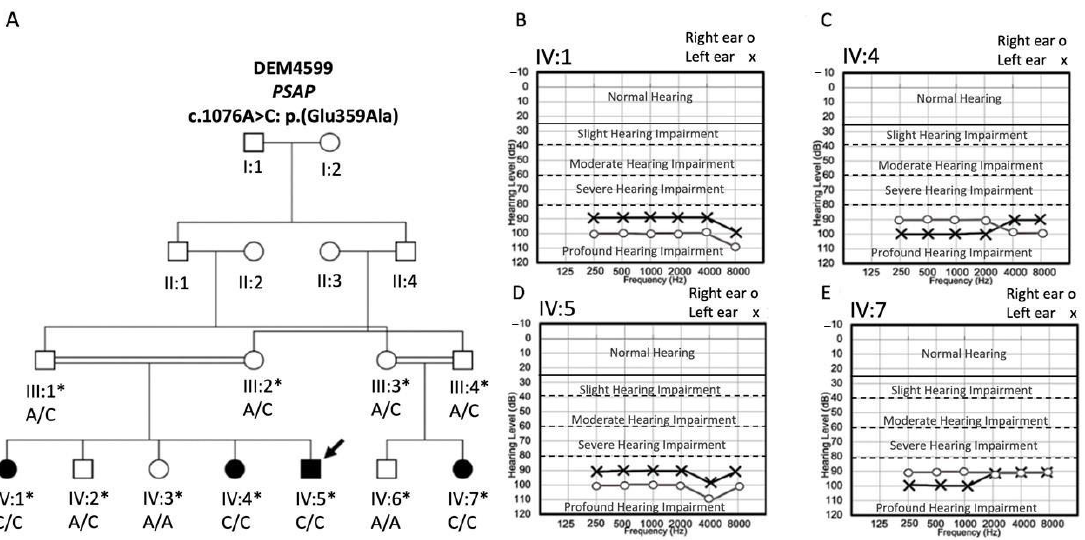
Figure 1. Pedigree and audiograms for family DEM4599. ( A ) Pedigree drawing of family DEM4599 segregating GD with an autosomal recessive mode of inheritance. Circles represent females and squares males. Filled symbols indicate affected family members and clear symbols unaffected members. Double lines in the pedigree represent a consanguineous marriage. Asterisks indicate individuals for whom a DNA sample is available, and an arrow indicates the sample selected for exome sequencing. Below each family member the PSAP c.1076A>C genotype is displayed. Audiograms of the affected individuals of the family DEM4599 ( B ) IV:1 (12 years of age), ( C ) IV:4 (14 years of age), ( D ) IV:5 (20 years of age), and ( E ) IV:7 (19 years of